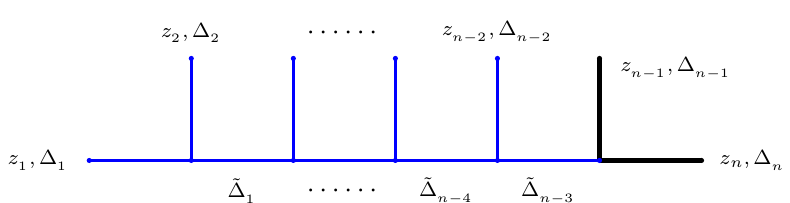
Figure 9 . The n -point conformal block with two heavy background primary operators depicted by two bold black lines. Misha, make all z and deltas smaller pls.